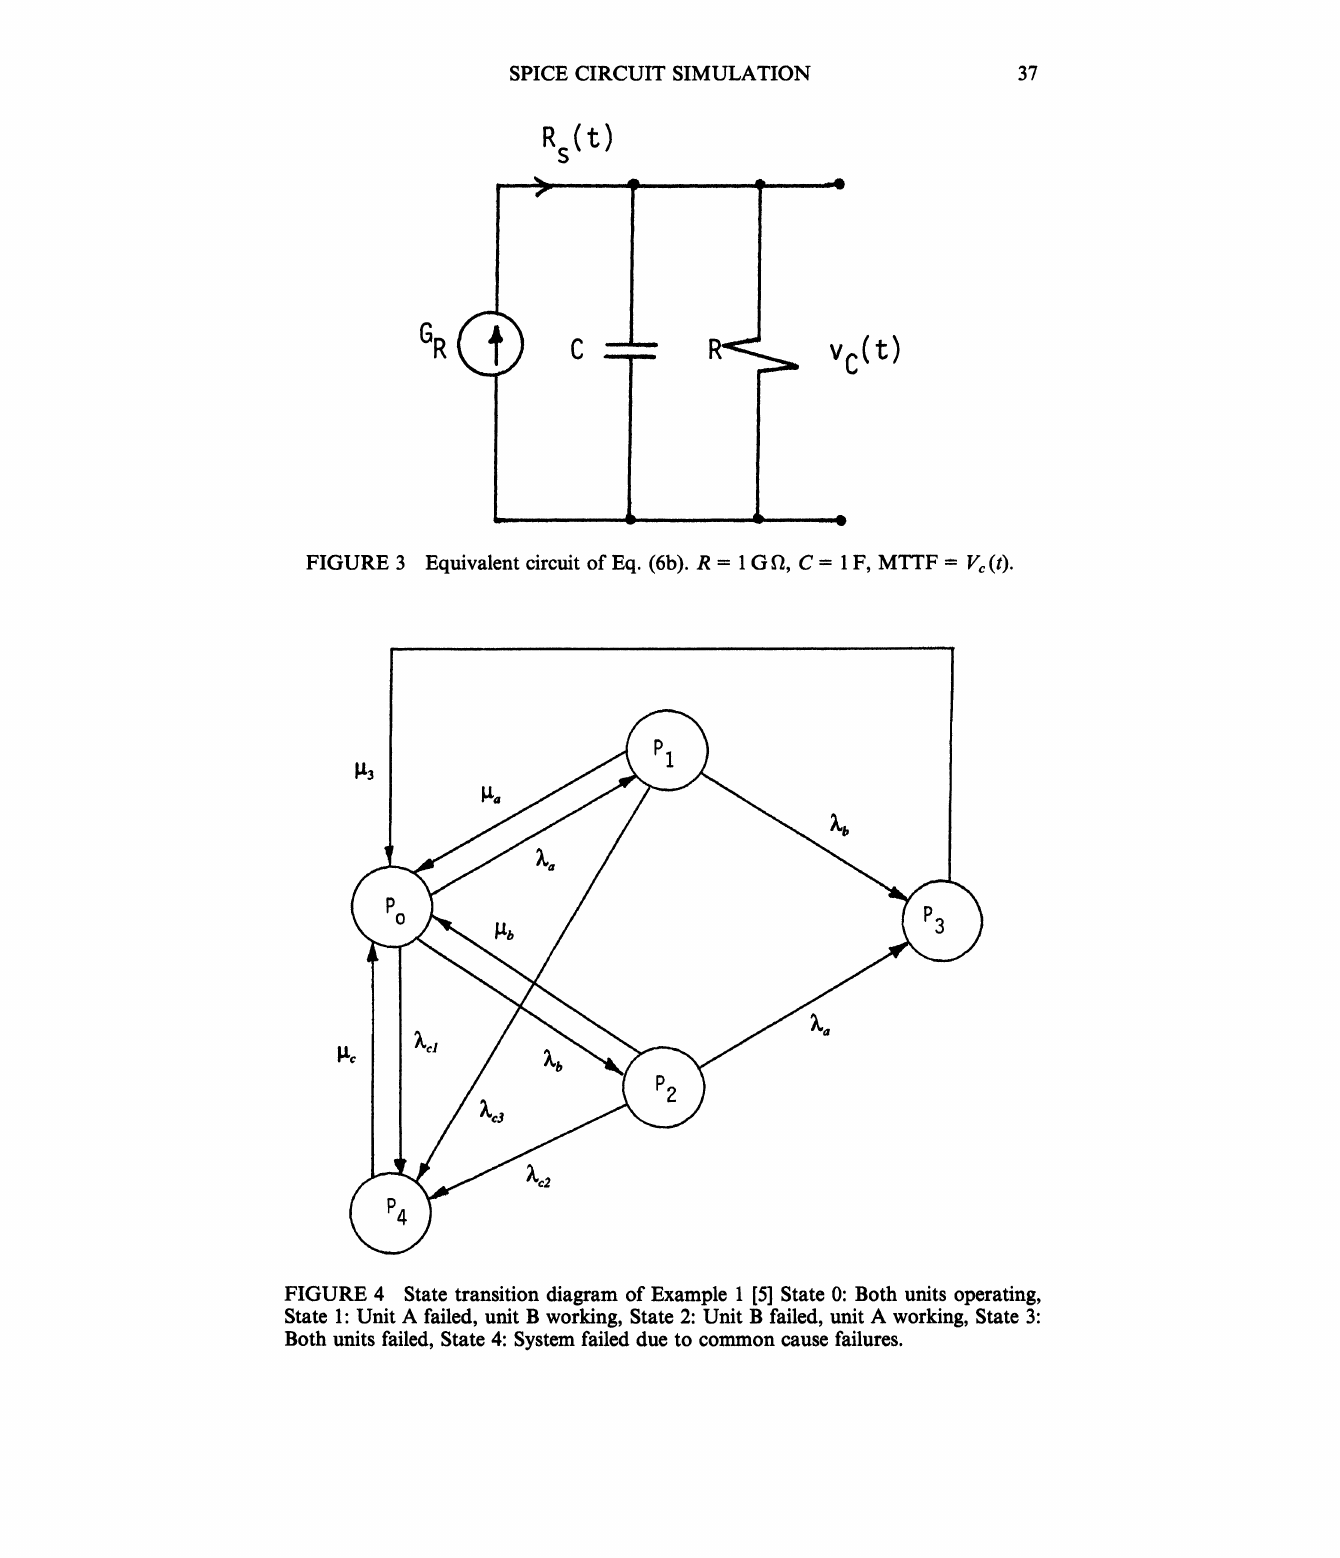
FIGURE 3 Equivalent circuit of Eq. (6b). R G f, C F, MTTF Vc (t).